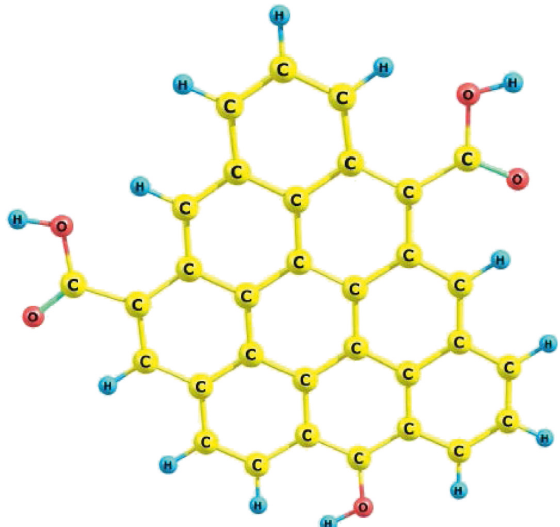
Figure 2: Schematic representation of graphene